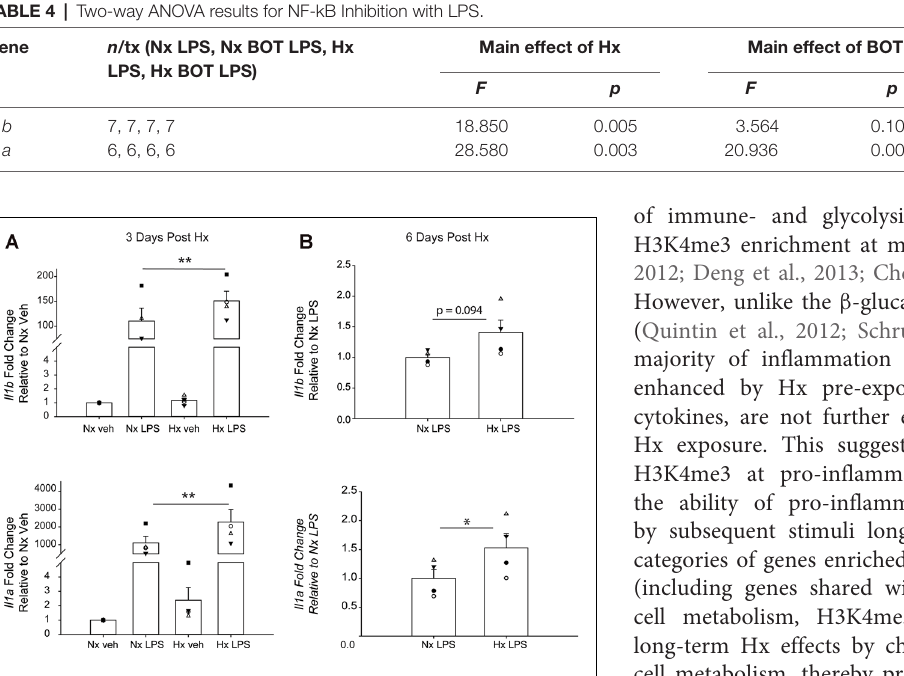
FIGURE 9 | Microglia exhibit gene-specific memory of hypoxia exposure that lasts for several days. Primary microglia were cultured overnight in Nx or Hx. The cells were washed with fresh medium containing MCSF, and then cultured for 3 (A) or 6 (B) days in Nx. Cells were then treated with LPS (100 ng/ml) for 3 h and harvested for qRT-PCR analysis of inflammatory gene expression. (A) Cells were cultured for 3 days post-Hx, treated with LPS, and harvested for qRT-PCR analysis of Il1b (top) and Il1a (bottom). Values are expressed as the average fold change ± SEM relative to Nx vehicle of n = 4 independent experiments. ∗ p < 0.05, ** p < 0.01 vs. Nx LPS; two-way RM ANOVA. (B) Cells were cultured for 6 days post-Hx. Values are